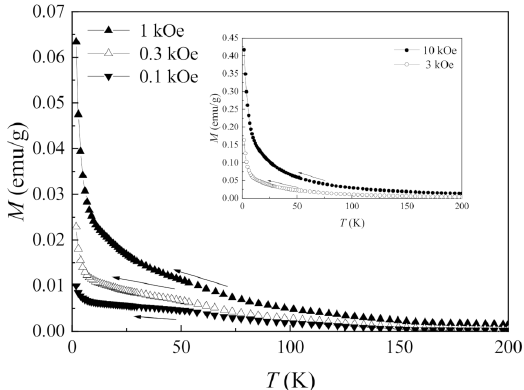
Figure 4. Temperature dependences of the magnetization for the nanocomposite sample, measured in fields of different strengths.